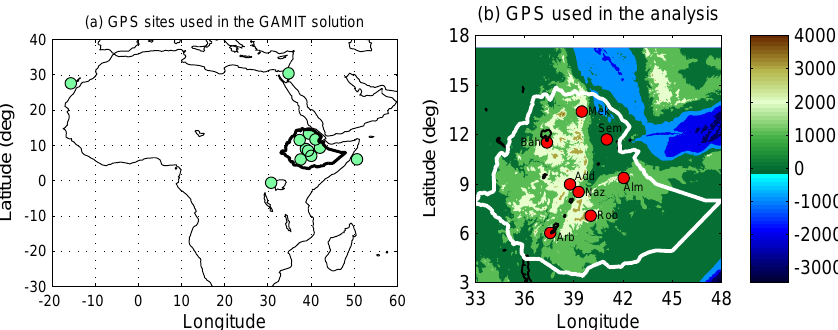
Figure 1. UNAVCO GPS ground receiver sites used in GPS solution using GAMIT software over the region (a) and locations of GPS receivers used in the analysis of PWV, nearby lakes and topography of the country (altitude in metres) (b) . The green circles show sites of GPS stations used in the GAMIT network solution. The red circles represent eight GPS sites considered in the analysis. Lakes are shown by the black contour lines. The smaller lakes appear in the map as dots due to the scale. The full names of the stations corresponding to short names in the map are given in Table